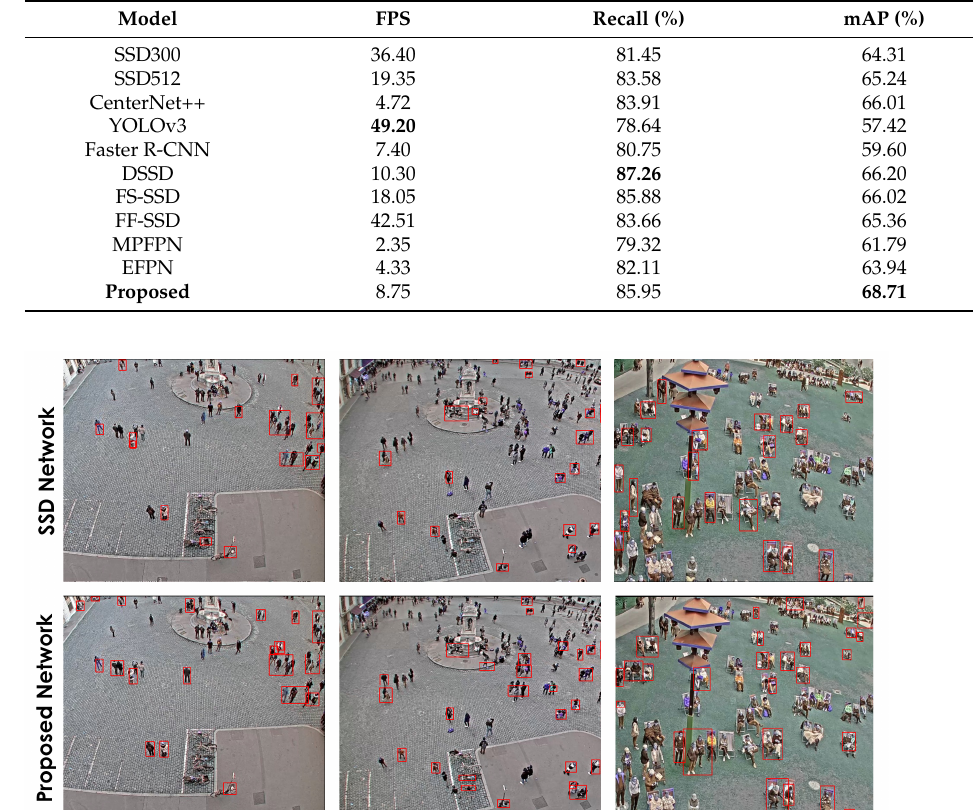
Figure 12. Comparison of small object detection of our proposed network (bottom row) with the SSD network (top row) onthe Pedestrian category from the Stanford drone dataset. Table 3. The mAP, Recall, and FPS comparison of the proposed model with state-of-the-art small object detectors on a subset of SDD dataset containing aerial images. Some of the general purpose object detectors have been included in this comparison.